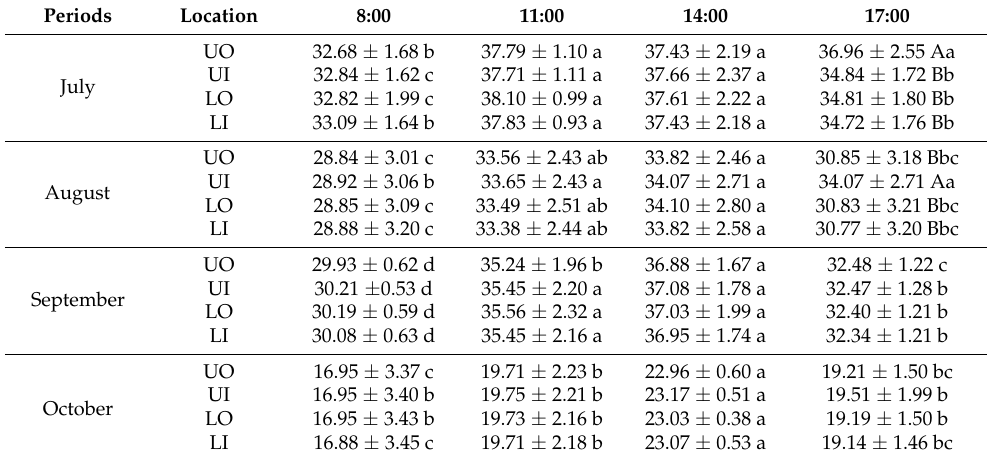
Table 1. The variations of temperature ( ◦ C) at different times of the day in different canopy positions. Periods